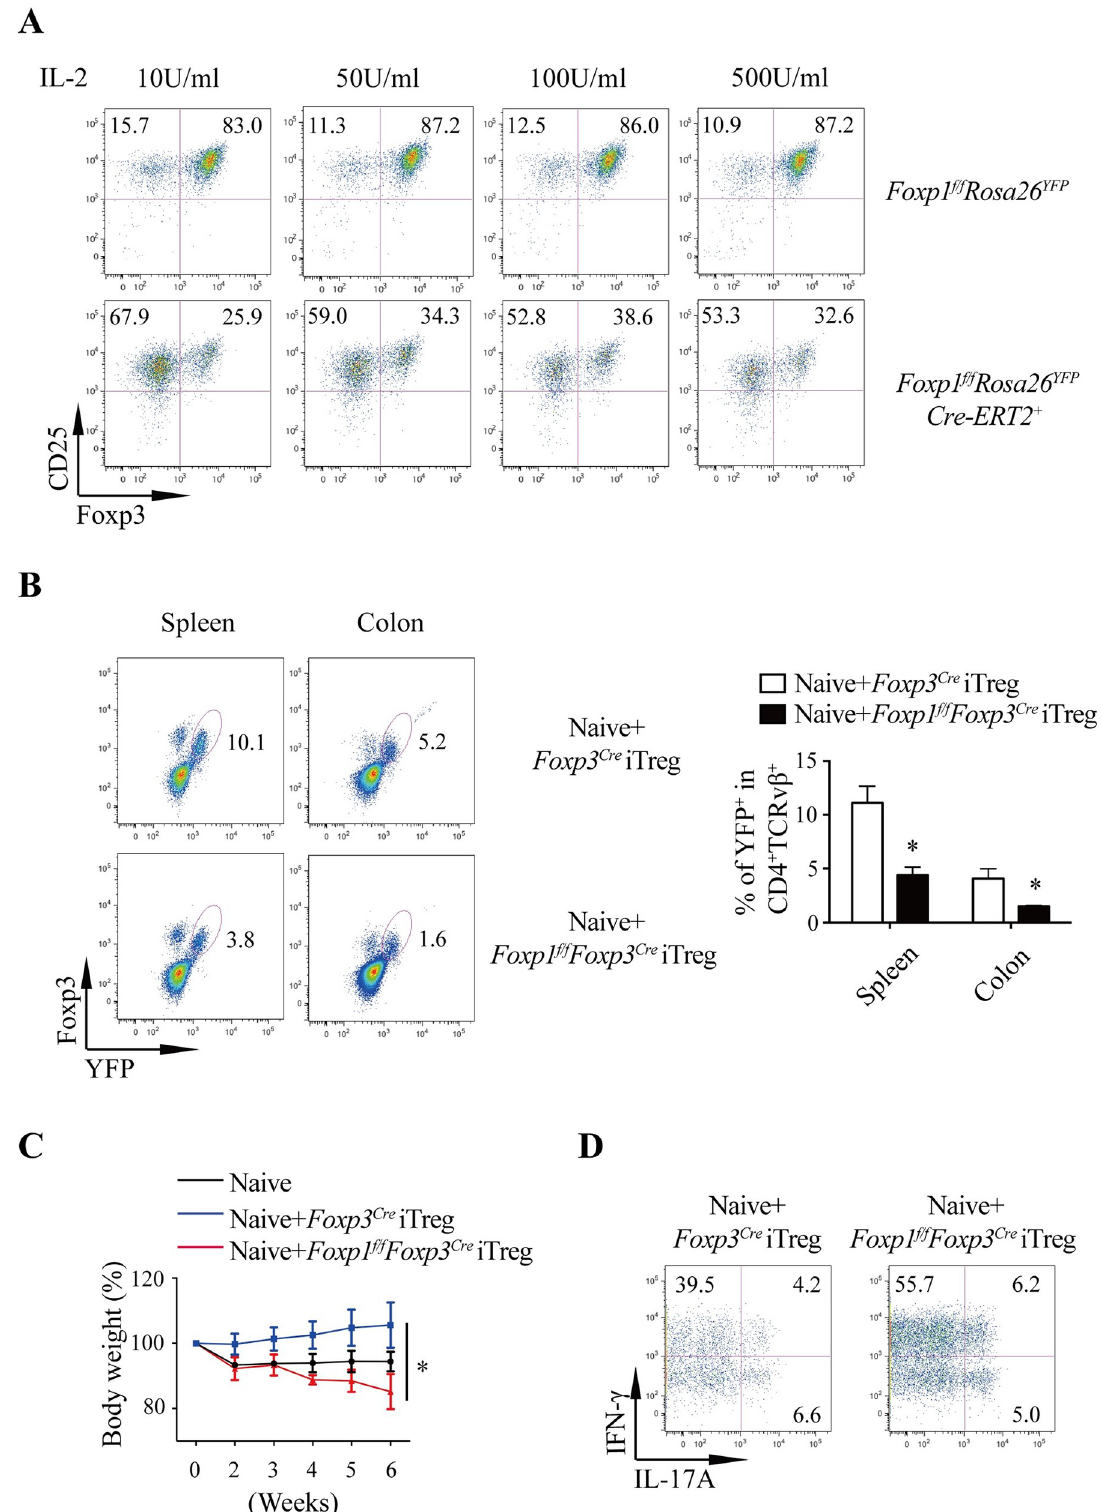
Fig 5. Foxp1 regulates iTreg cell differentiation and maintenance. (A) Foxp1 f/f Rosa26 YFP and Foxp1 f/f Cre-ERT2 + Rosa26 YFP mice were treated with tamoxifen for 6 days, and CD4 + T cells were isolated and cultured in the plate coated with 1 μ g/mL